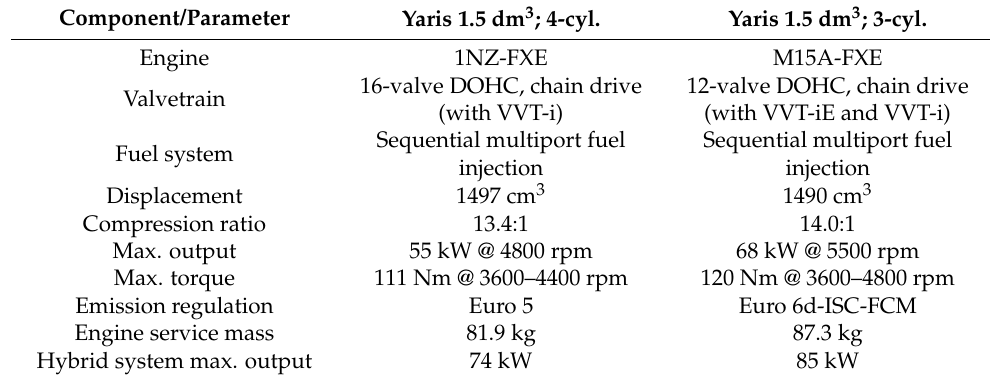
Table 1. Engine characteristics [18–20].